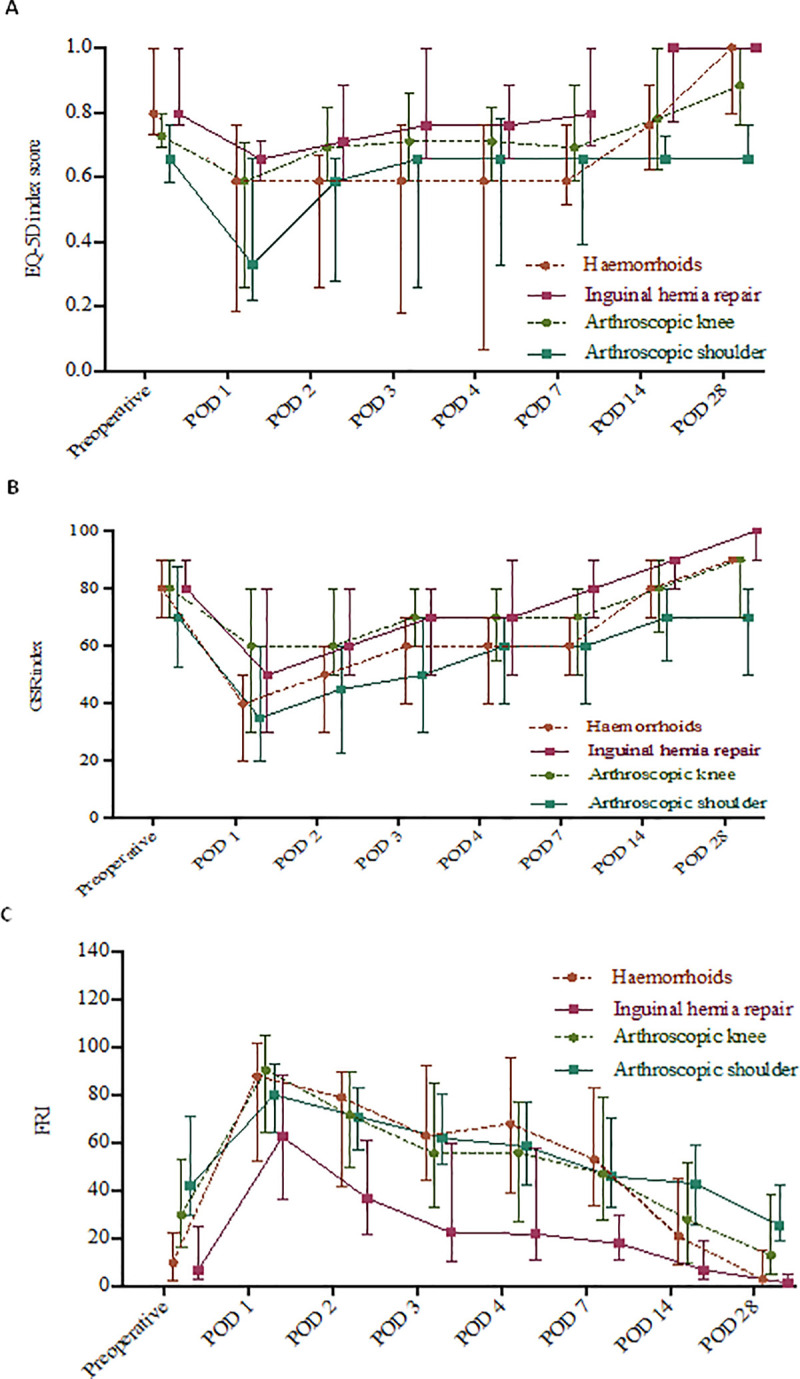
Median and interquartile range of EQ-5D index scores (A), GSR index scores (B) and FRI total scores (C).